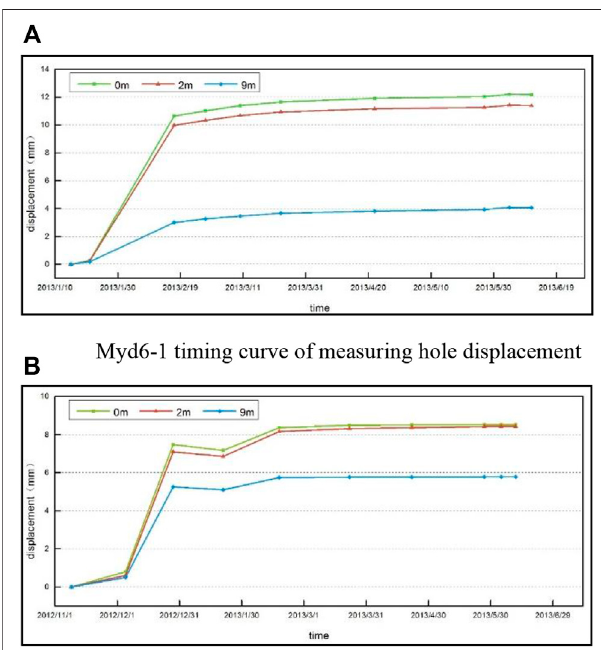
FIGURE 6 | Displacement sequence curve. (A) Myd6-1 timing curve of measuringholedisplacement. (B) Myd6-4Timesequencecurveofmeasuring hole